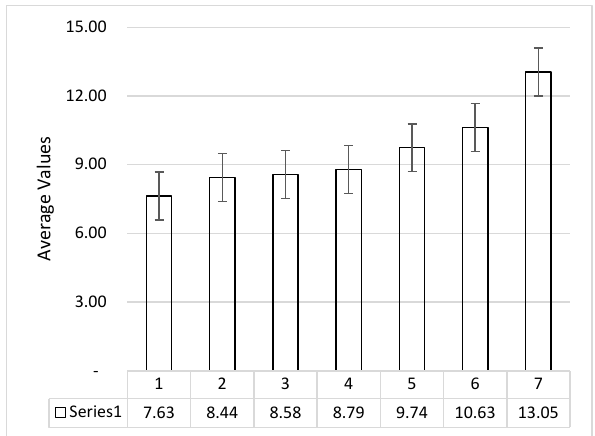
Figure 10. Stress vs. strain plot for ABS and ATA specimens.